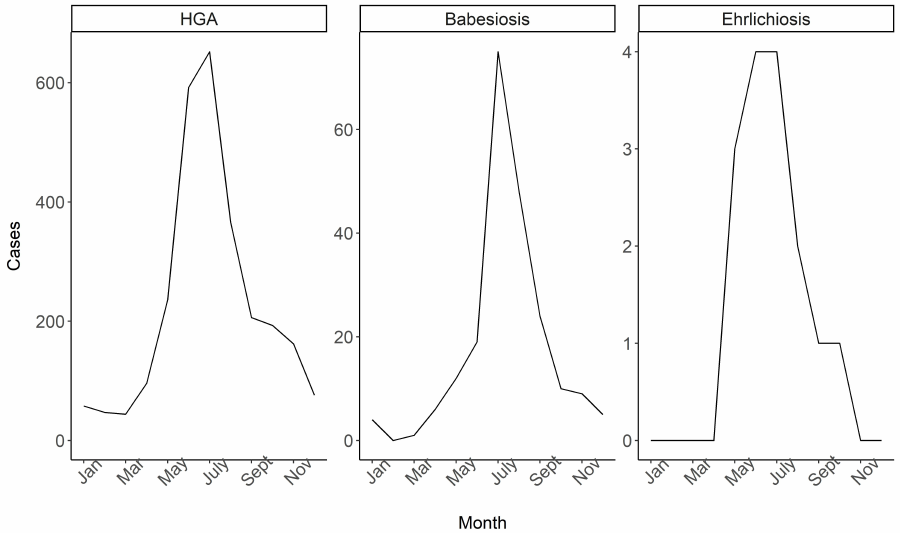
Figure 3. Counts of laboratory-positive non-Lyme tick-borne disease cases in the Marshfield Clinic Health System (MCHS) by disease type from 2000–2016 stratified by